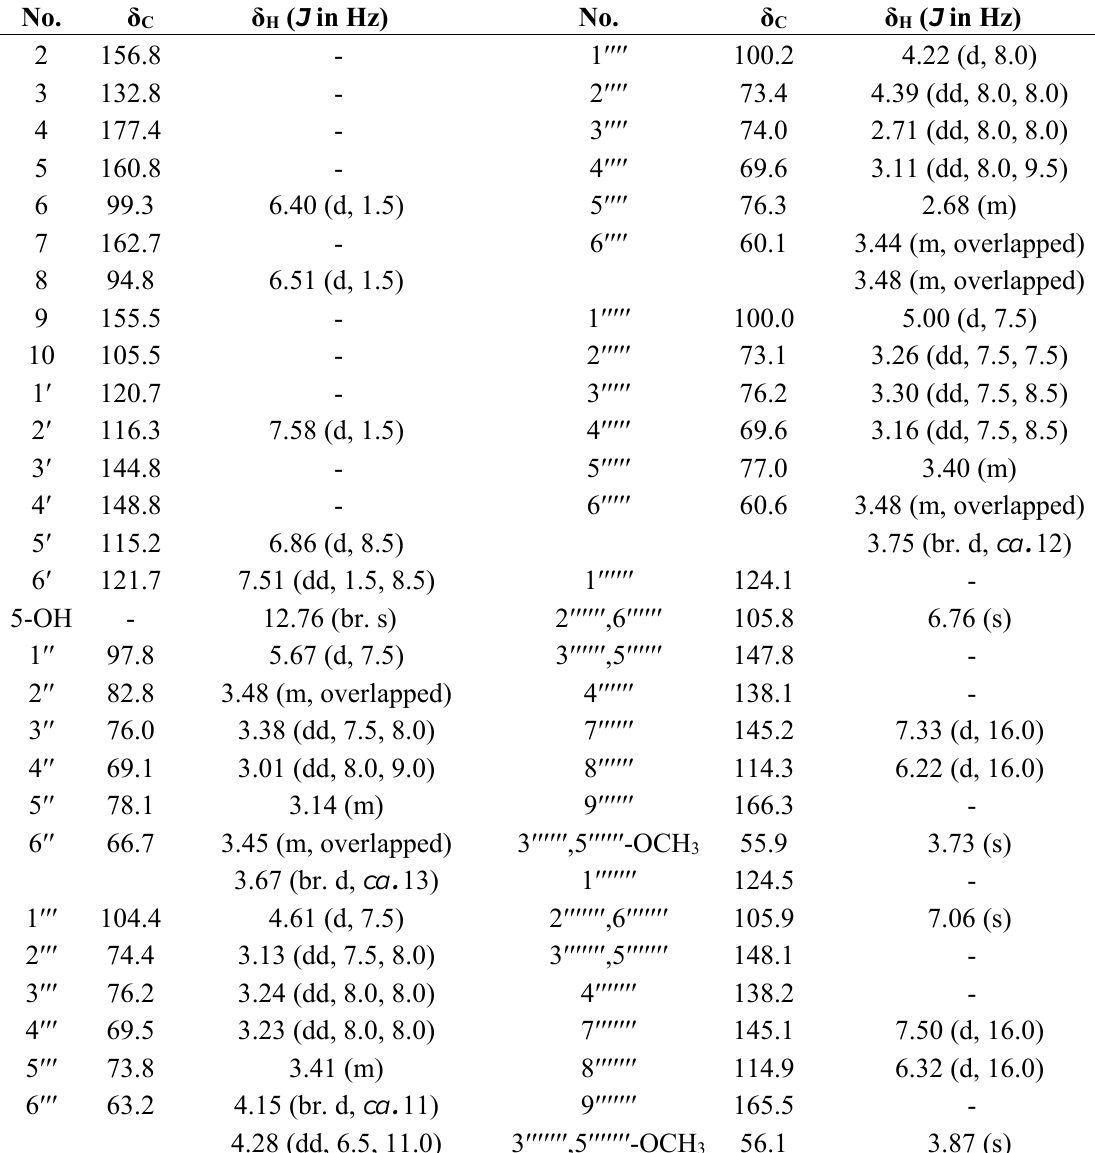
Table 6. 1 H and 13 C-NMR data for 6 in DMSO- d 6 (500 MHz for 1 H and 125 MHz for 13